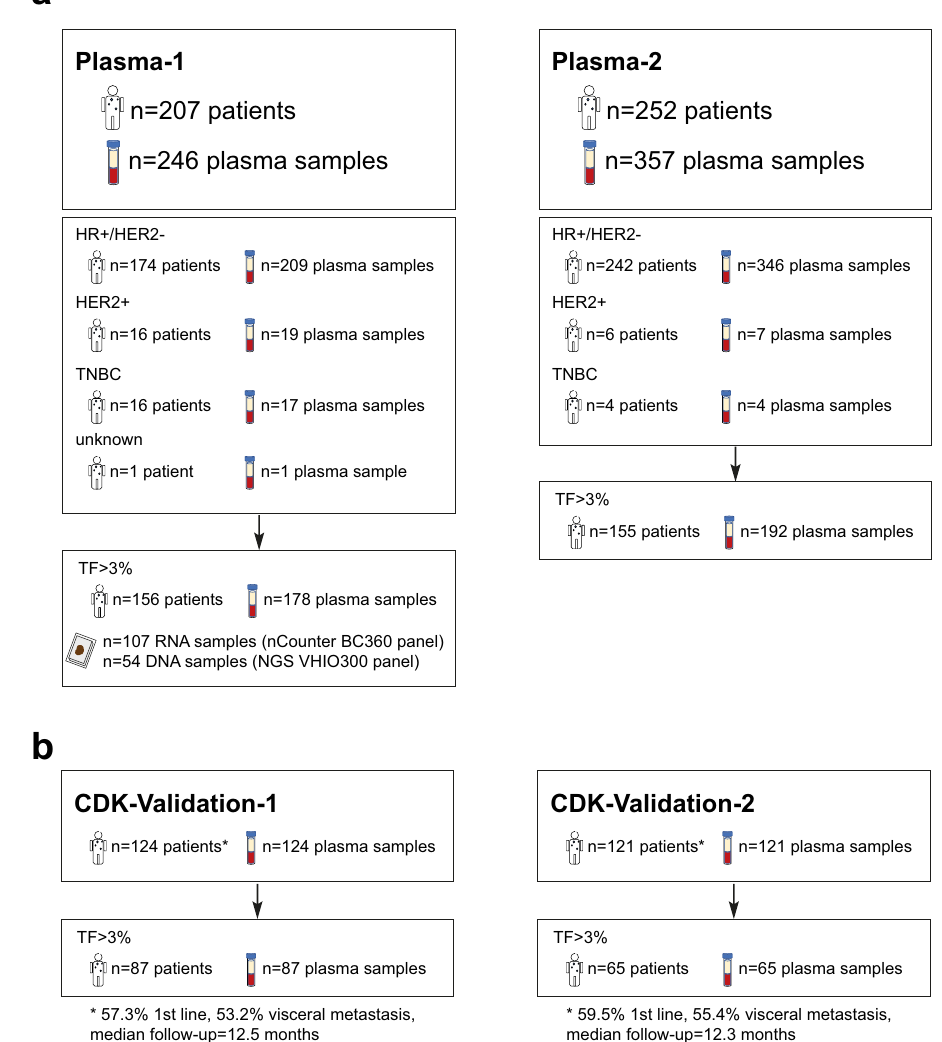
Fig. 1 | Summary ofplasma samples usedin the study. a Description of plasma samples obtained from patients with advanced breast cancer across Plasma-1 and Plasma-2 cohorts. b Description of samples from patients with advanced